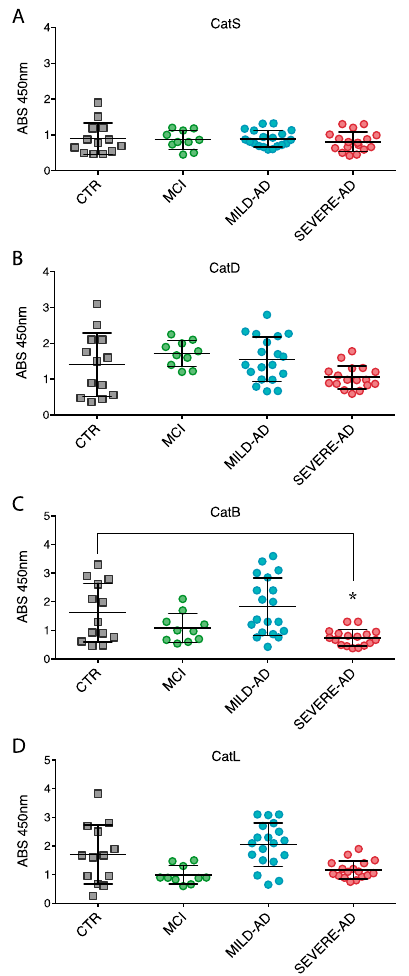
Figure 3. Lysosomal proteases expression ( A – D ) in PBMCs of mild AD, severe AD, MCI, and control subjects. Levels of proteases were determined by Western blotting. Shown are the densitometry measurements of all analyses. Results were expressed as the mean ± SEM of five independent experiments, each in triplicates. * p < 0.05.